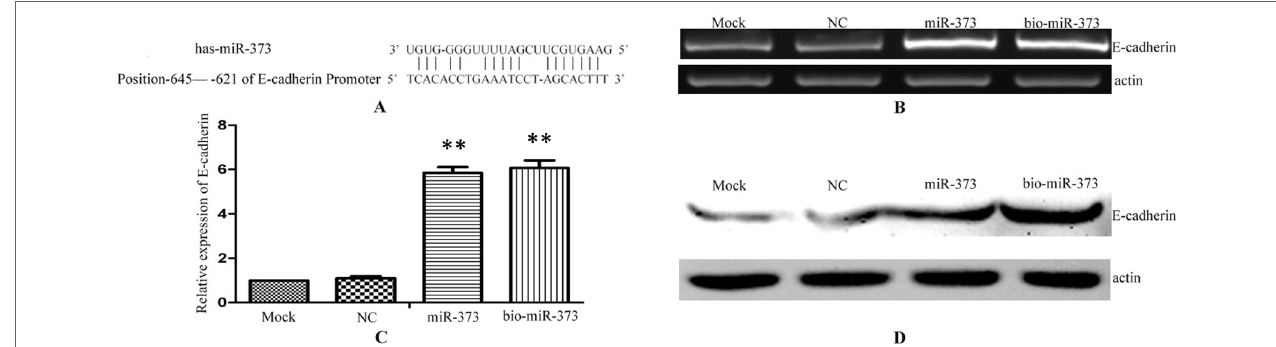
FIGURE 2 | Biotinylated miR-373 can regulate the expression of E-cadherin. (A) The identified miR-373 binding site in E-cadherin promoter. MCF-7 cells were transfected with miR-373, NC miRNA, or bio-miR-373 for 48 h. Then semi-quantitative PCR (B) , real-time PCR (C) , and Western blotting (D) were performed to detect the expression of E-cadherin. n = 3, ** P < 0.01 compared with the sample transfected with NC miRNA.